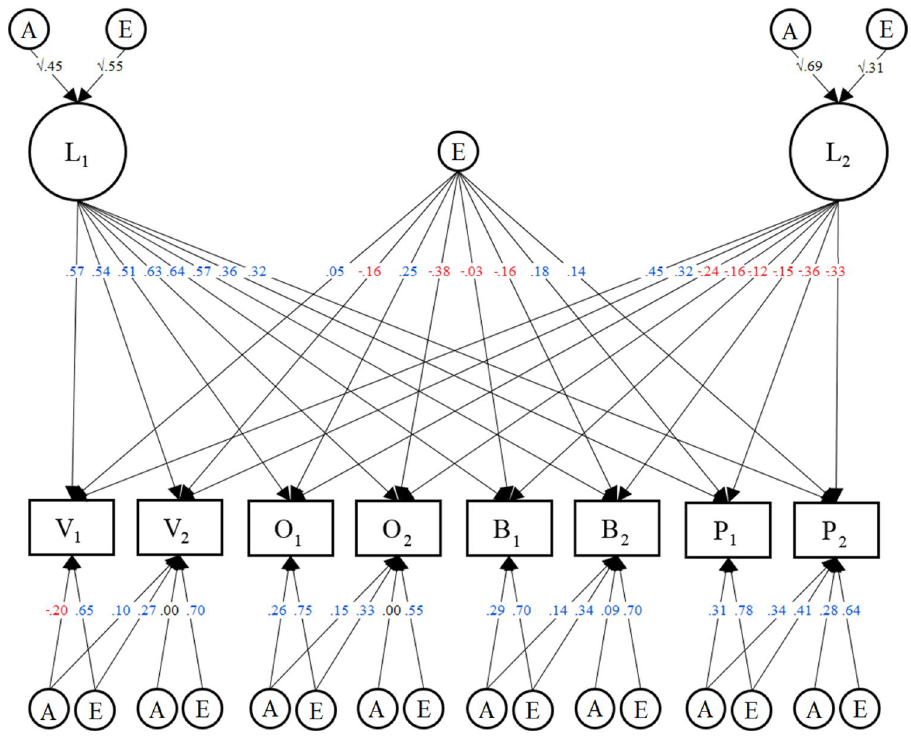
Figure 4. Best fitting biometric factor model. Illustration of our best fitting biometric factor model. Blue numbers are positive and red numbers are negative.